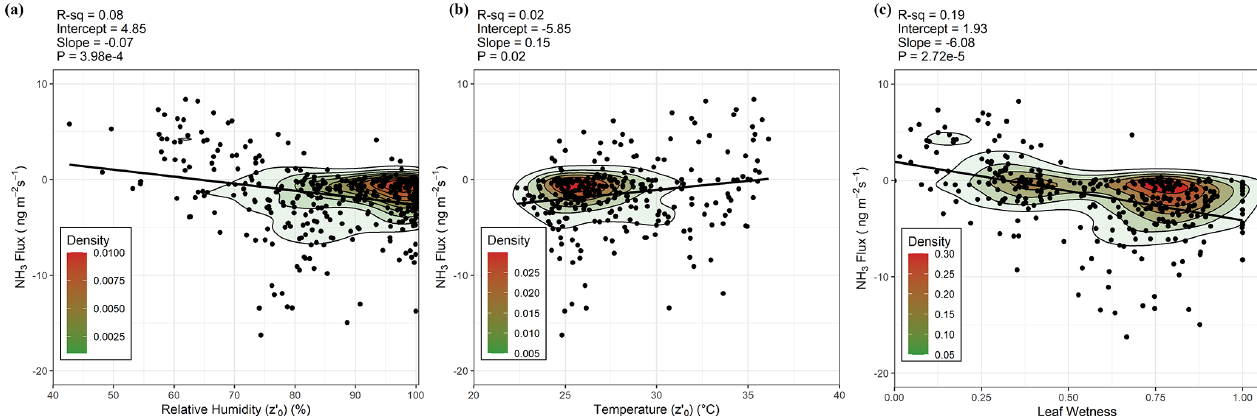
Figure 3. Scatter plots with line of best fit and data density shadings for NH 3 flux against (from a to c ) relative humidity at z (cid:48) , and leaf wetness at z (cid:48) 0